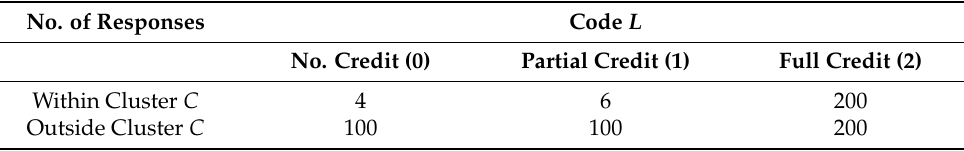
Table 2. Example of a response distribution of an assigned